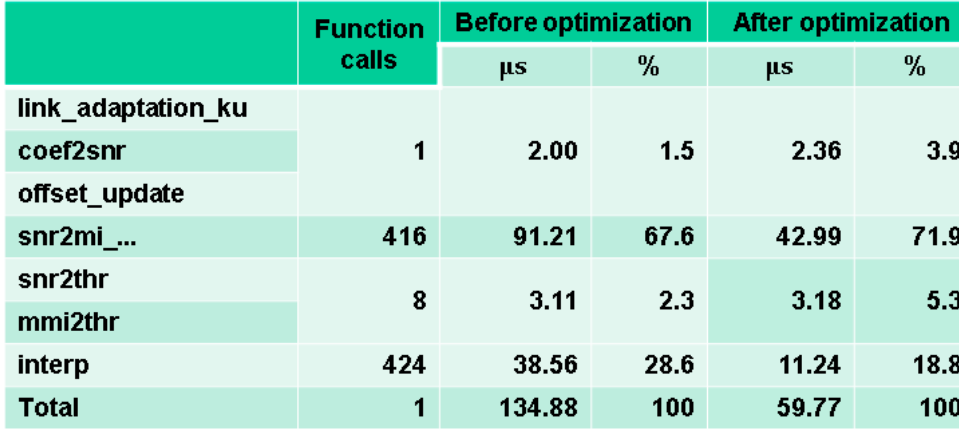
Figure 15. Execution time and ratio of each function before and after